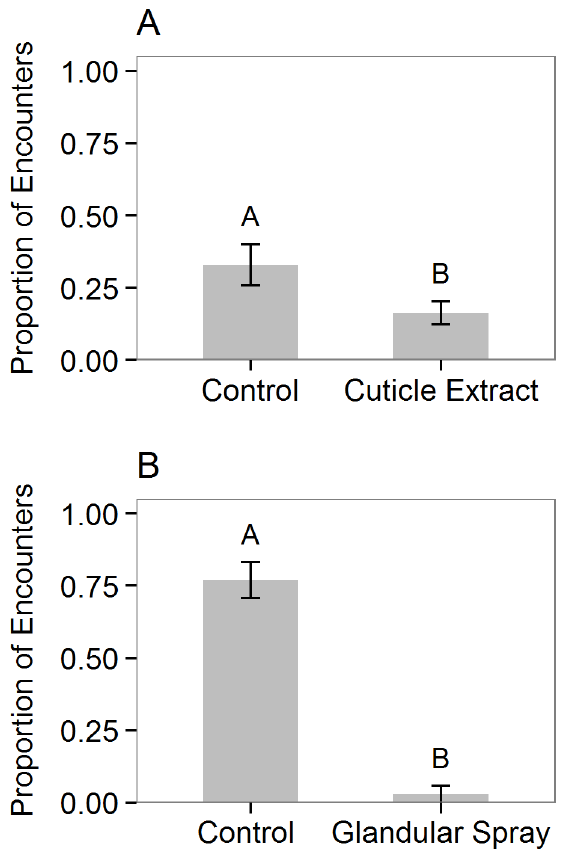
Figure 2. Response of Pseudomyrmexspinicola ants to isolated compounds from Piezogaster reclusus . Bars show the mean proportion ( 6 SE) of encounters in which Pseudomyrmex spinicola ants attacked cotton swabs that were treated with Piezogaster reclusus (A) cuticular compounds or (B) glandular compounds in comparison to controls. Letters indicate significant differences from binomial GLMMs that included ant colony as a random effect.